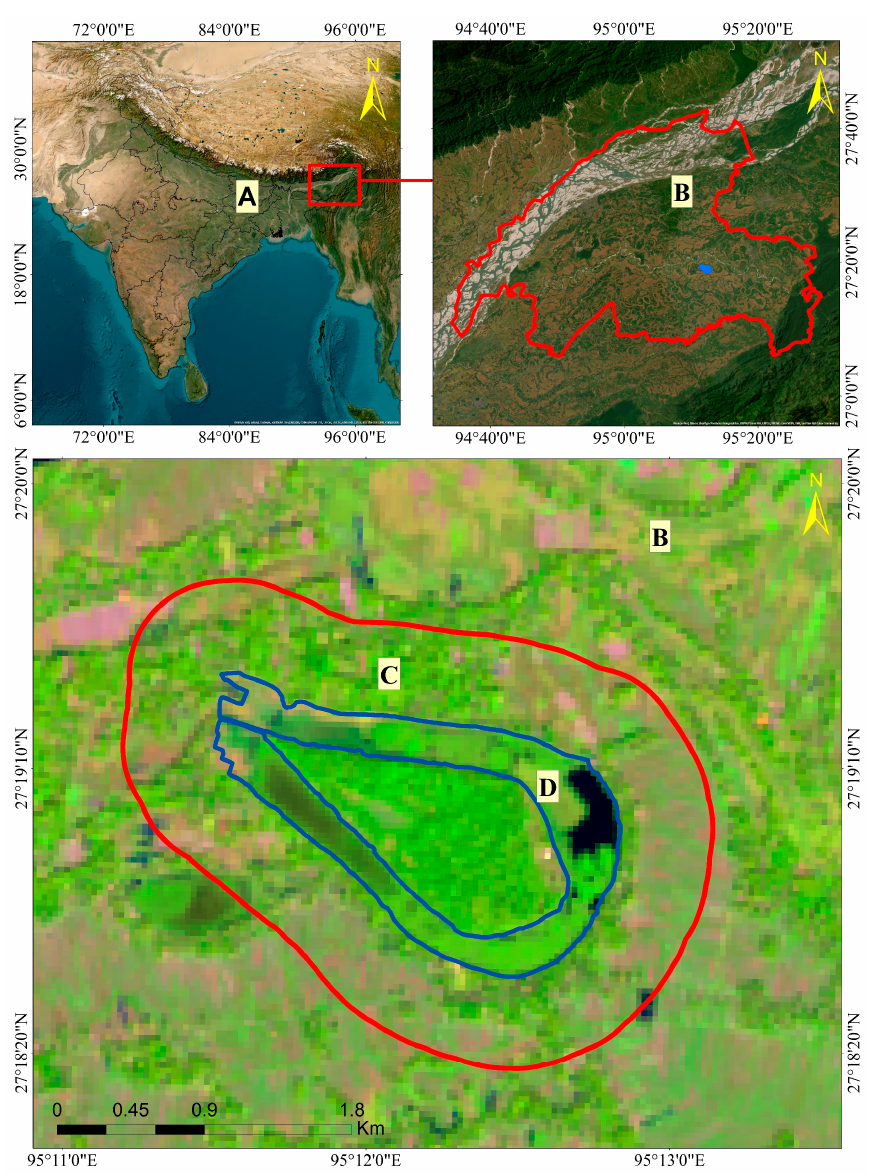
Figure 1. The map illustrates the location of the Merbil wetland within the broader geographical context. The red line encircles a 500-meter buffer zone surrounding the wetland. Key features include: ( A ) marking the boundary of India, ( B ) denoting the Dibrugarh district, ( C ) signifying the 500-meter buffer zone from the wetland, and ( D ) identifying the wetland itself. This visualization highlights the spatial relationship between the wetland and its surrounding areas, emphasizing the importance of understanding the potential impacts of land use and environmental changes on the wetland